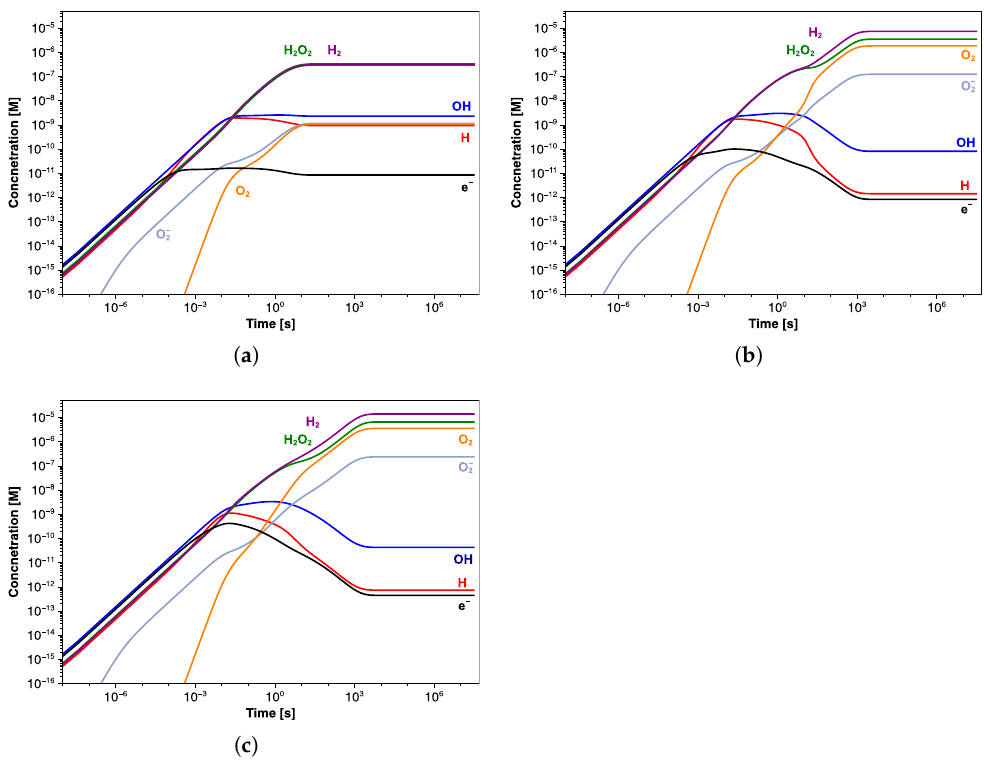
Figure 7. Concentration profiles of the main radiolytic products as a function of exposure time at pH 60 ( a ) 6.5, ( b ) 7, and ( c )